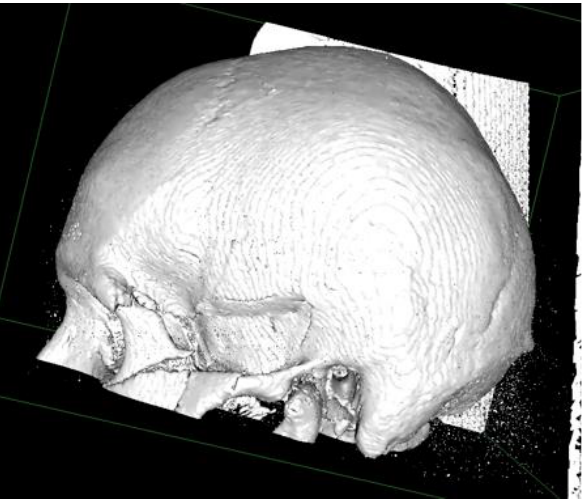
Figure 3. Reconstruction from a 3D-CT trauma scan of the major cranio-facial fractures.